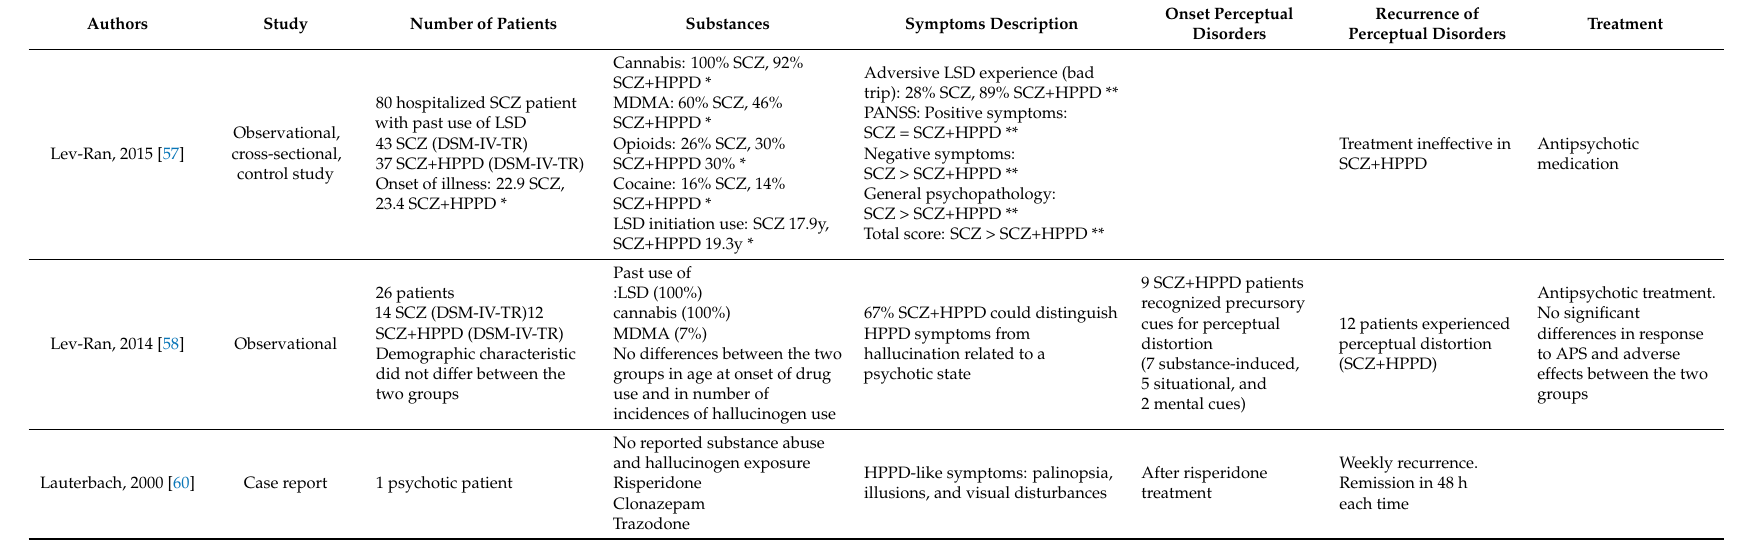
Table 3. Observational studies and case reports comparing schizophrenic patients with HPPD (SCZ+HPPD) and schizophrenic patients without HPPD (SCZ) (* p > 0.05, ** p <